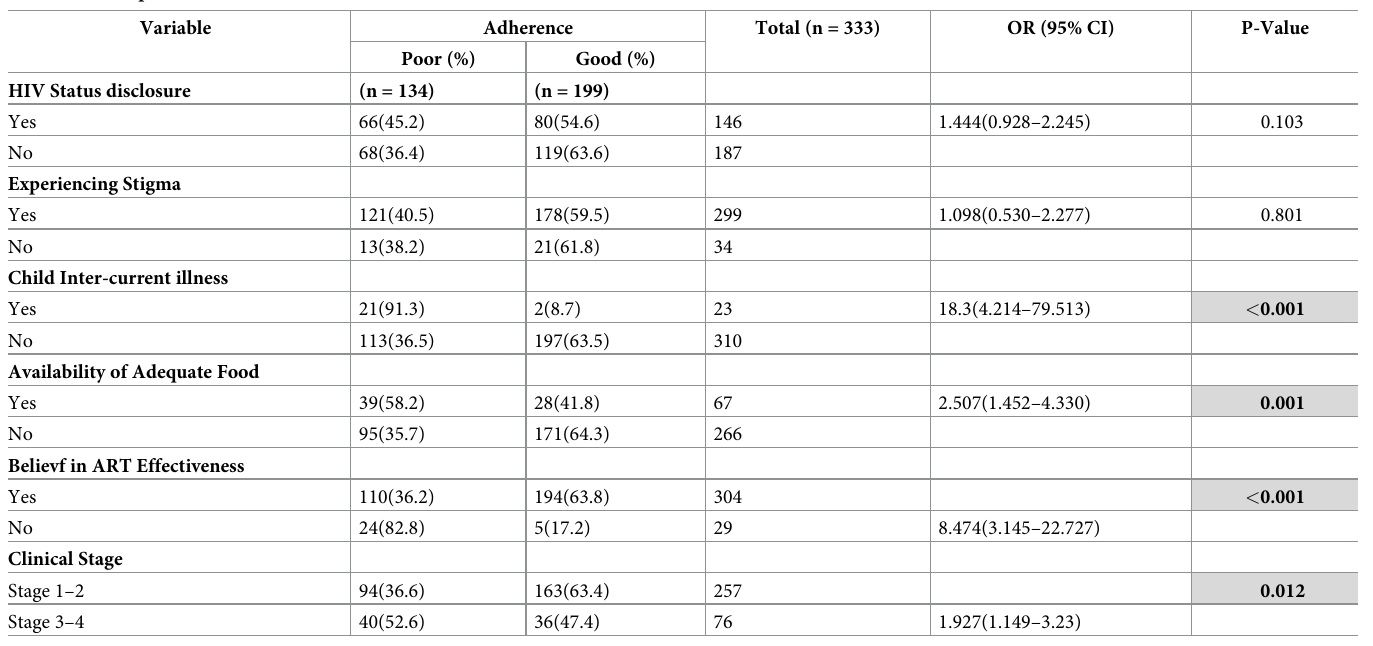
Table 3. Participant characteristics associated with ART adherence.